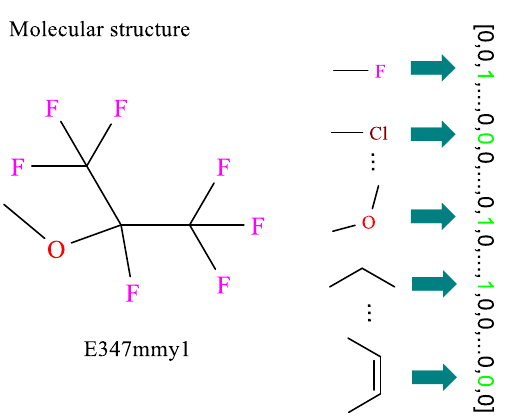
Figure 1. Schematic diagram of fingerprint of a molecule.